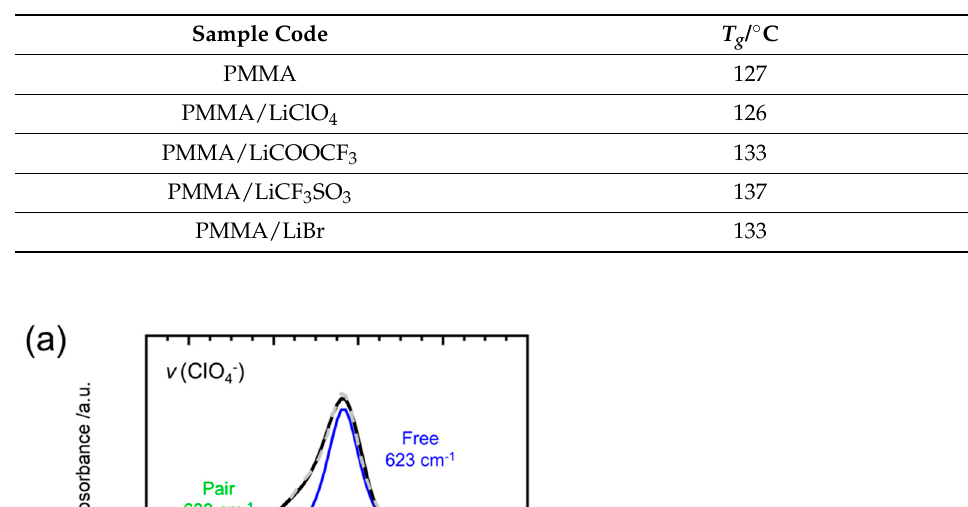
Table 1. The values of T g for the prepared PMMA/salt samples with [Li]/[C=O] = 0.07.